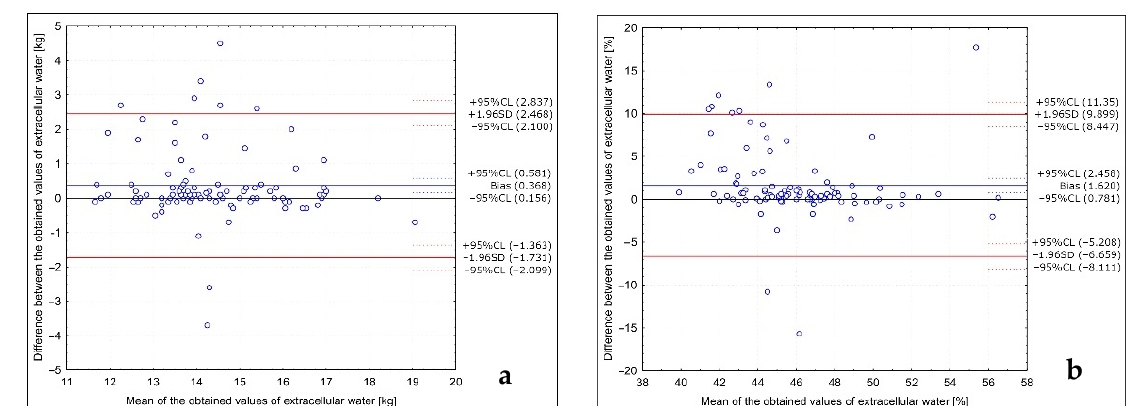
Figure 2. Analysis of the Bland–Altman plots comparing the extracellular water results in the studied group of Caucasian young normal body mass women measured in the follicular phase in various positions (with arms abducted at least 30 ◦ and legs abducted at approximately 45 ◦ ; with arms and legs separated to not touch the body) for the results in kg ( a ) and in the % ( b ).